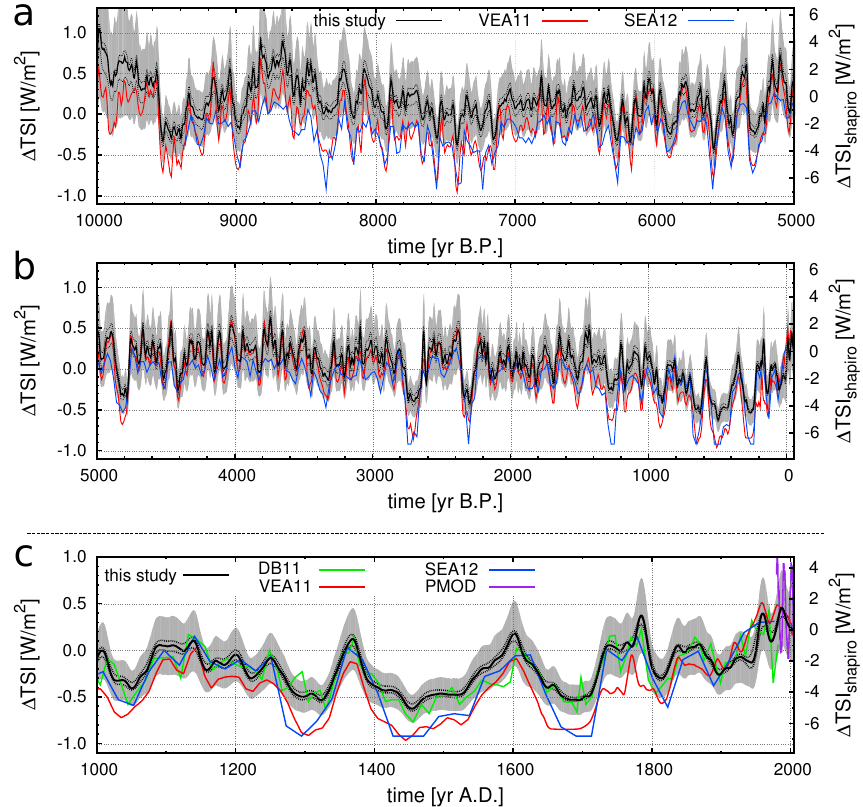
Fig. 14. (a, b) Total solar irradiance deviation from solar cycle minimum value in 1986 (assumed to 1365.57Wm − 2 ) calculated in this study (black with grey 1 σ error, left y axis), and the reconstructions by Vieira et al. (2011) (VEA11, red) and Steinhilber et al. (2012) (SEA12, blue). The dotted lines indicate the uncertainty introduced by random errors from the 1 14 C history alone excluding any systematic errors. (c) Magnification of the last 1000yr; in addition to VEA11 and SEA12 the data of Delaygue and Bard (2011) (DB11, green) is shown as well as the composite record from the Physikalisch-Meteorologisches Observatorium Davos (PMOD). The DB11 record has been aligned to the other records by adding an offset of 0.5Wm − 2 . The right y axis shows the corresponding TSI variations when applying the 8 –TSI scaling of Shapiro et al. (2011) to our 8